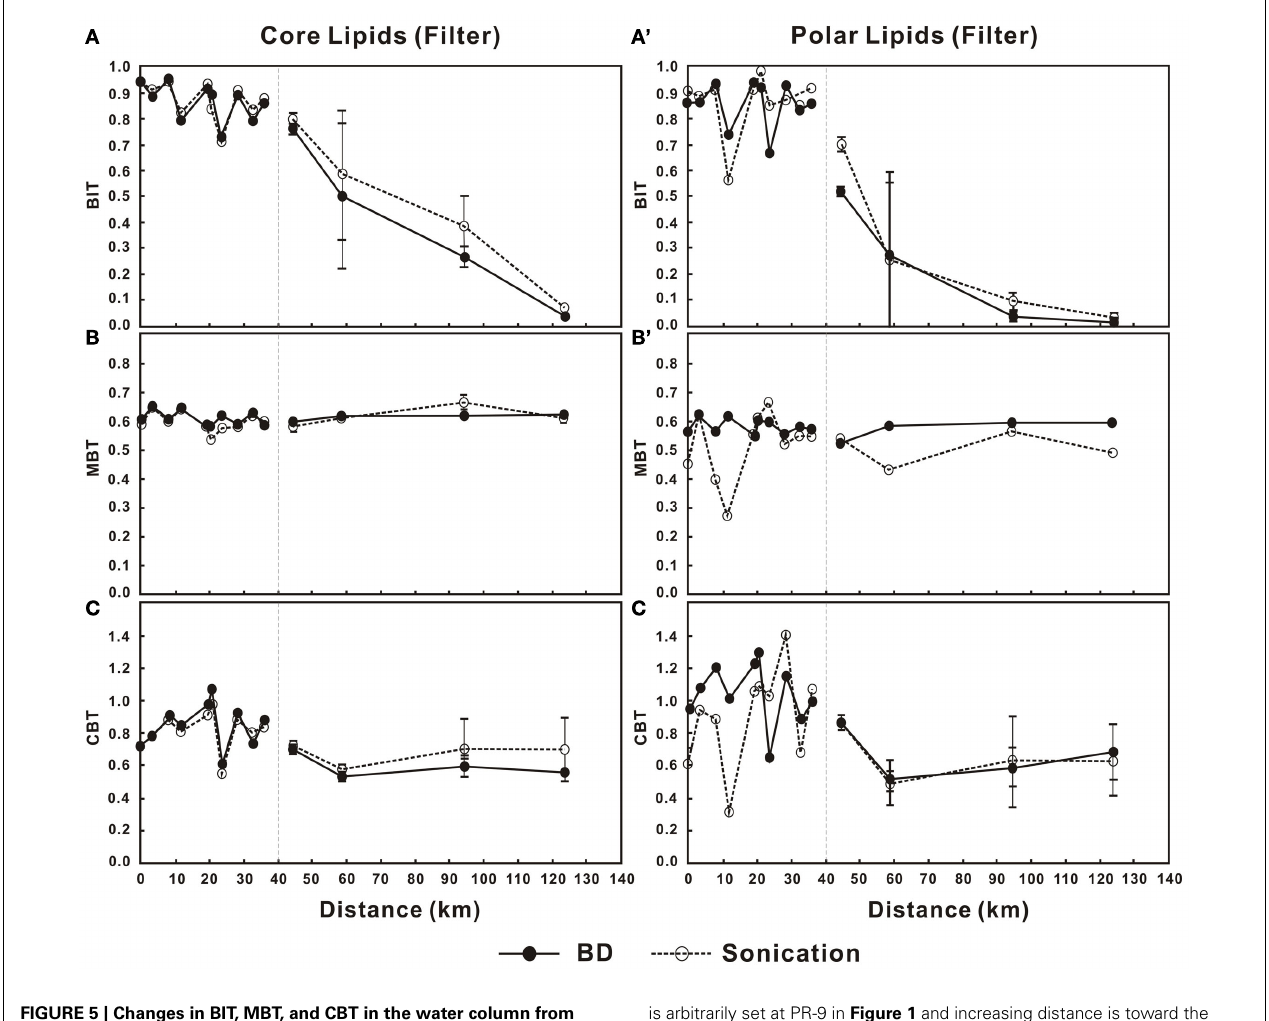
is arbitrarily set at PR-9 in Figure 1 and increasing distance is toward the estuary.The error bars in each panel represent SD of the average values between the surface water- and the bottom water samples in the